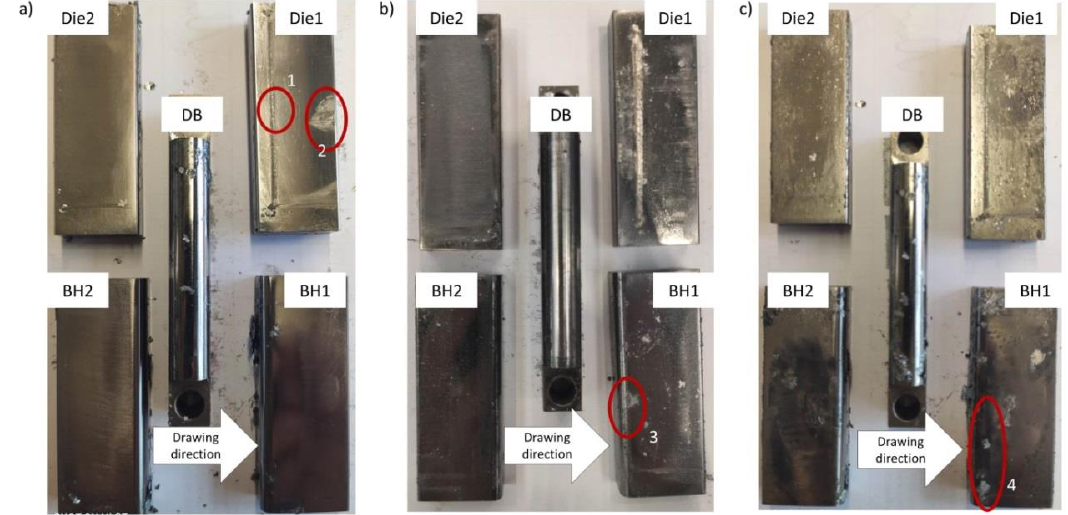
Figure 25. Wear marks on test tools after severe wear occurrence: ( a ) 1.2379 with hardness HRC 58; ( b ) EN-GJS-700-2 with hardness HRC 58; ( c ) EN-GJS-700-2 with hardness HRC 48.